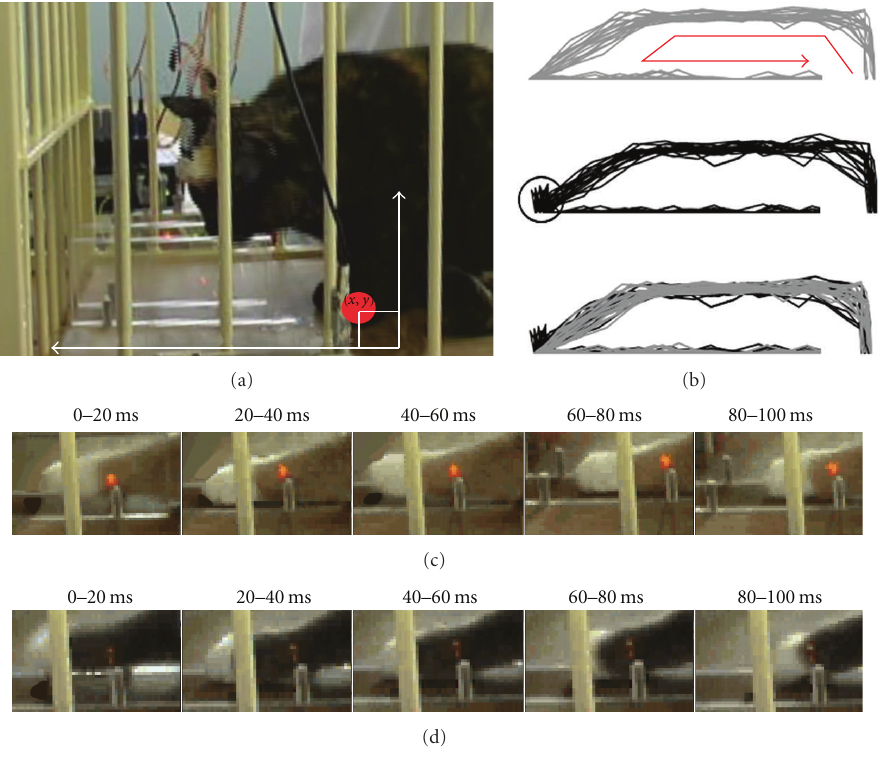
Figure 2: Kinematic analysis of task performance. Frame-by-frame analysis was performed using MATLAB in order to create two dimensional trajectory traces for the reaching movement in the coronal and horizontal planes. The coordinates were derived by locating the central point of the animal’s reaching paw at each separate frame of video footage (a). In (b), the results of trajectory analysis for dataset 4 are displayed for successful (top) and unsuccessful (middle) trials. The red arrow inside the successful trajectory trace indicates the direction of the reaching motion, and the final trajectory trace (bottom) is the result of overlaying the successful and unsuccessful traces. Note the clear similarity in the trajectory paths of the successful and unsuccessful trials, but the slight di ff erence at the end of the reach phase of the movement (circled) created by a second (or occasionally third) attempt at grasping the food pellet during unsuccessful trials. Finally, an example of frame-by-frame analysis that was performed at the end of the reaching stage (as the food pellet was secured) that allowed for the classification of trials as either unsuccessful (c) or successful (d). Note the slightly prolonged ending of the reach stage in “(c)” as the animal needs to make another attempt to grasp the food pellet; while at similar frames in “(d)”, the commencement of the withdrawal stage had already